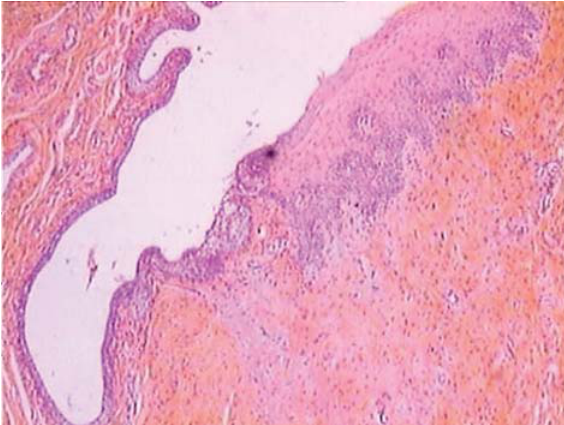
Figure 3 – The buccal mucosa graft three weeks after surgery. Extensive neovascularization was evident in the subepithelial (cid:79)(cid:68)(cid:92)(cid:72)(cid:85)(cid:3)(cid:90)(cid:76)(cid:87)(cid:75)(cid:3)(cid:68)(cid:3)(cid:86)(cid:87)(cid:85)(cid:72)(cid:68)(cid:80)(cid:76)(cid:81)(cid:74)(cid:3)(cid:82)(cid:73)(cid:3)(cid:191)(cid:69)(cid:85)(cid:82)(cid:69)(cid:79)(cid:68)(cid:86)(cid:87)(cid:86)(cid:3)(cid:87)(cid:82)(cid:90)(cid:68)(cid:85)(cid:71)(cid:3)(cid:87)(cid:75)(cid:72)(cid:3)(cid:74)(cid:85)(cid:68)(cid:73)(cid:87)(cid:17)